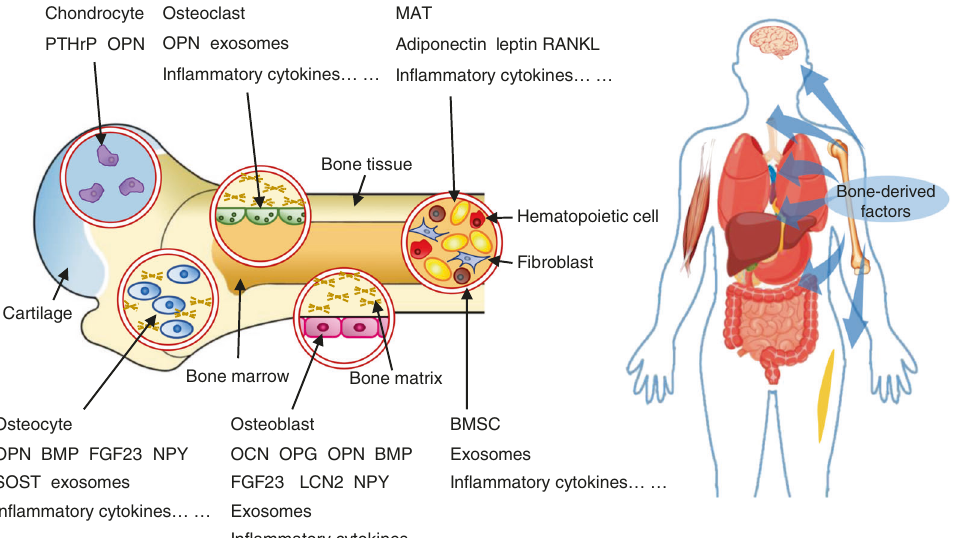
Fig. 1 The cells that make up bone mainly include osteocytes, osteoblasts, osteoclasts, and chondrocytes in bone tissue, as well as bone marrow mesenchymal cells and bone marrow adipocytes in the bone marrow cavity. Different cells can produce different endocrine factors, which can enter the blood circulation to regulate multiple organs in the